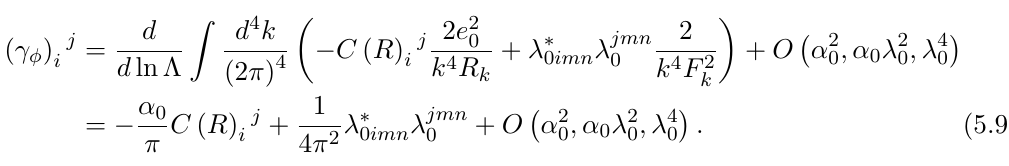
Figure 3 . One-loop graphs contributing to the renormalization of the chiral matter super(cid:12)elds. matter super(cid:12)elds. In the one-loop approximation it is de(cid:12)ned by the diagrams presented in (cid:12)gure 3. With the considered regularization they have been calculated in [68]. The result has the